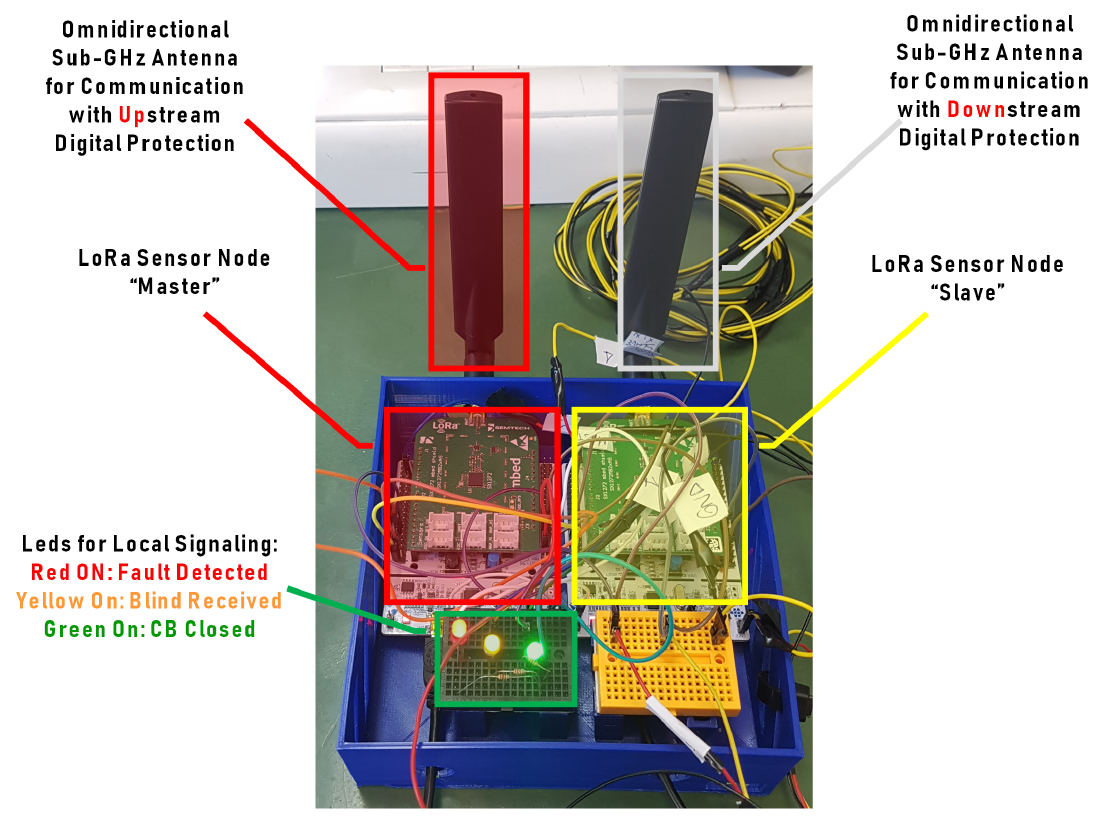
Figure 7. Image of the realized PR prototype.